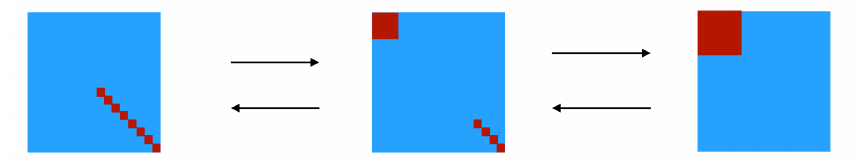
Figure 5 . A cartoon picture of the formation (left to right) and evaporation (right to left) of small black hole encoded into matrix degrees of